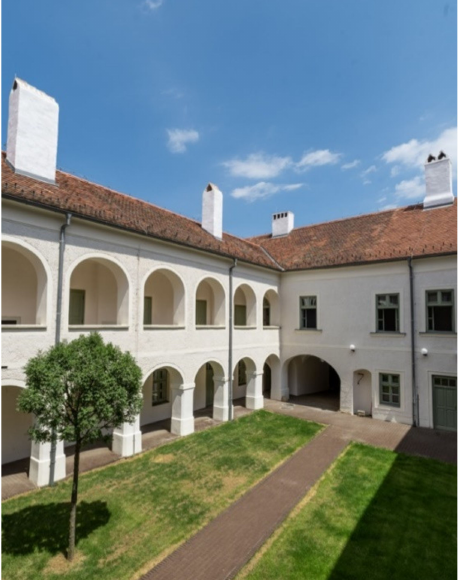
Figure 4. Imre Festetics lived in the town of K˝oszeg, Hungary in the castle displayed on the photograph. From his estates he travelled with his sheep to the meetings of SBS in Brno yearly since 1814. Photo by Bence Ga á l, courtesy of the Institute of Advanced Studies K˝oszeg